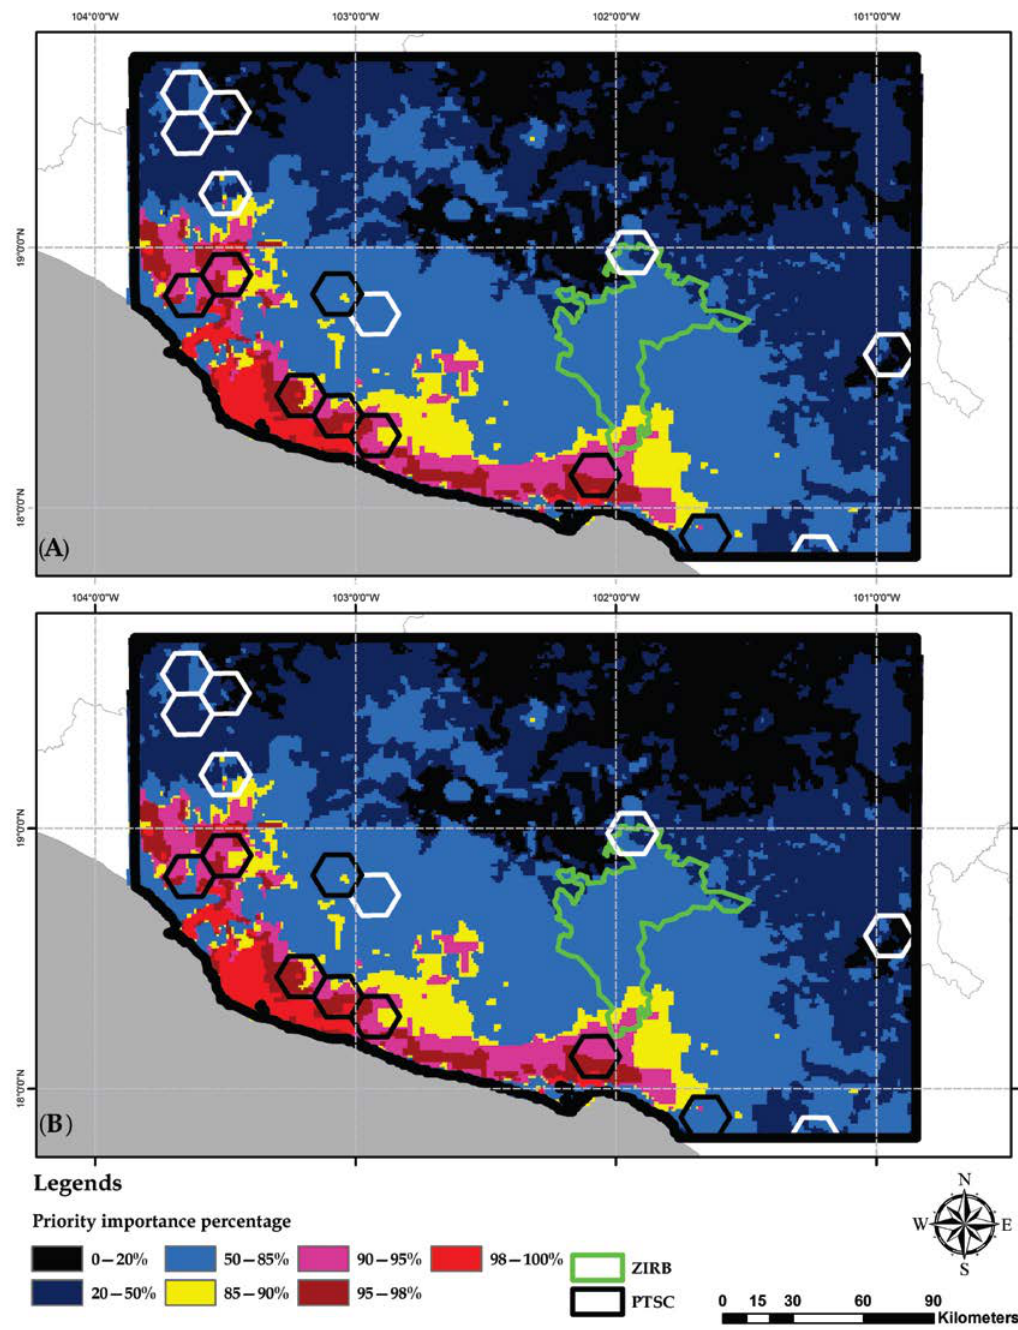
Figure 5. Spatial correspondence between prioritization models and existing proposed priority terrestrial sites (PTSC; CONABIO et al., 2007) shown as hexagons. Black hexagons represent correspondence of highest conservation importance. ( A ): Prioritization model obtained by applying the additive benefit function (ABF), weighted species, the boundary length penalty (BLP), and the inverted deforestation model. ( B ) Prioritization model obtained by applying the core area zonation (CAZ) elimination rule and the same parameters as in model A.